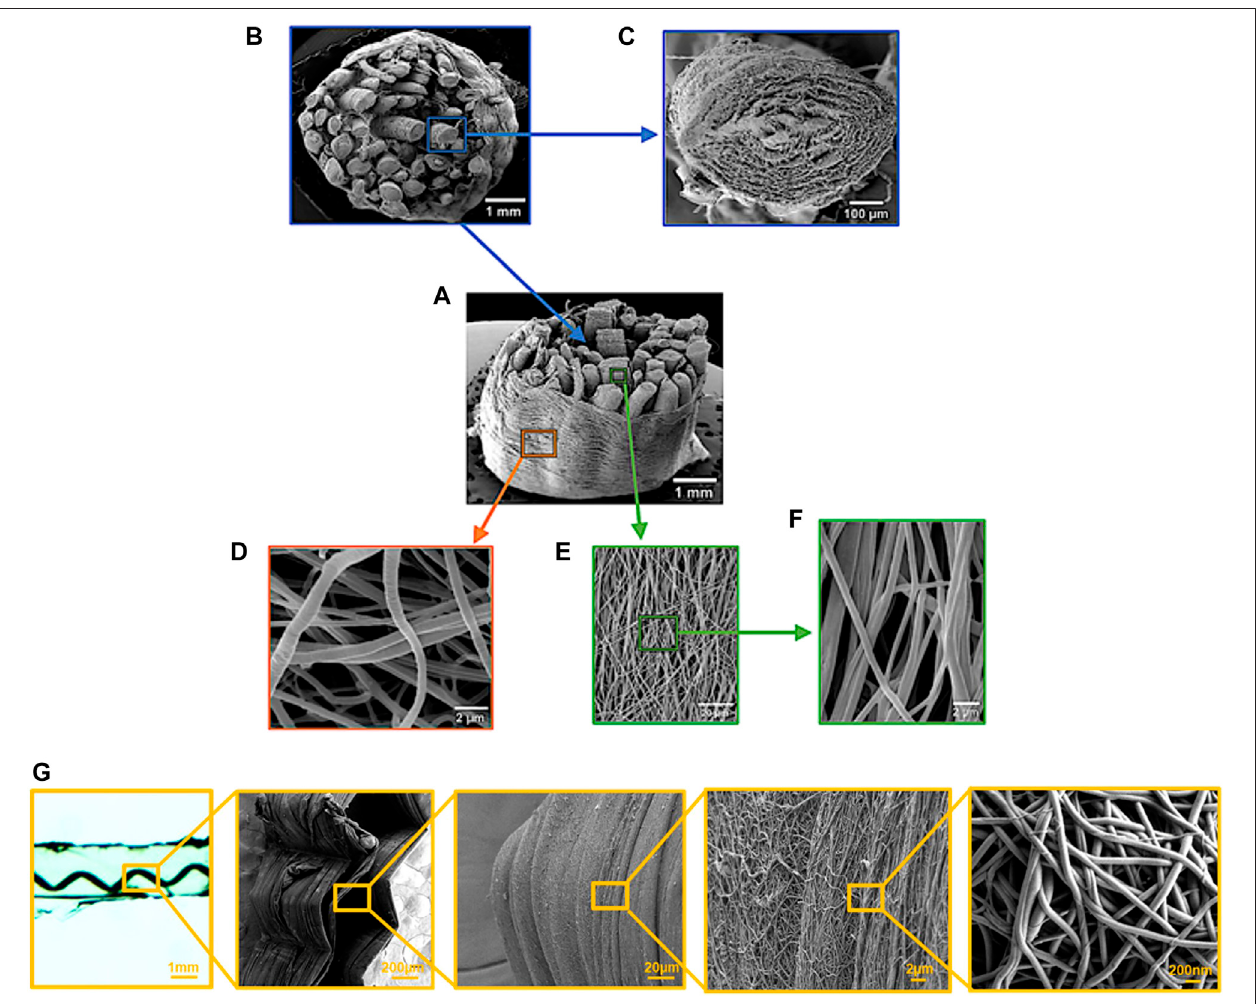
FIGURE 12 | Hierarchy in soft electrospun constructs. (A – F) PLLA multiscale hierarchical scaffold for ligament biomimetics. (A , B) Section of the multiscale hierarchical scaffold made of single bundles of aligned nano fi bers with the electrospun sheath epitenon/epiligament-like. (C) Section of a single bundle. (E , F) Aligned nano fi bers on the surface of a single bundle at different magni fi cations. Reprinted from (Sensini et al., 2019b) under CC-BY. (G) The hierarchical structure of crimped polyamide-soft alginate composite. Right-to-left- from electrospun nano fi bers to hierarchical soft composite. Reprinted from (Sharabi and Wagner, 2021) with